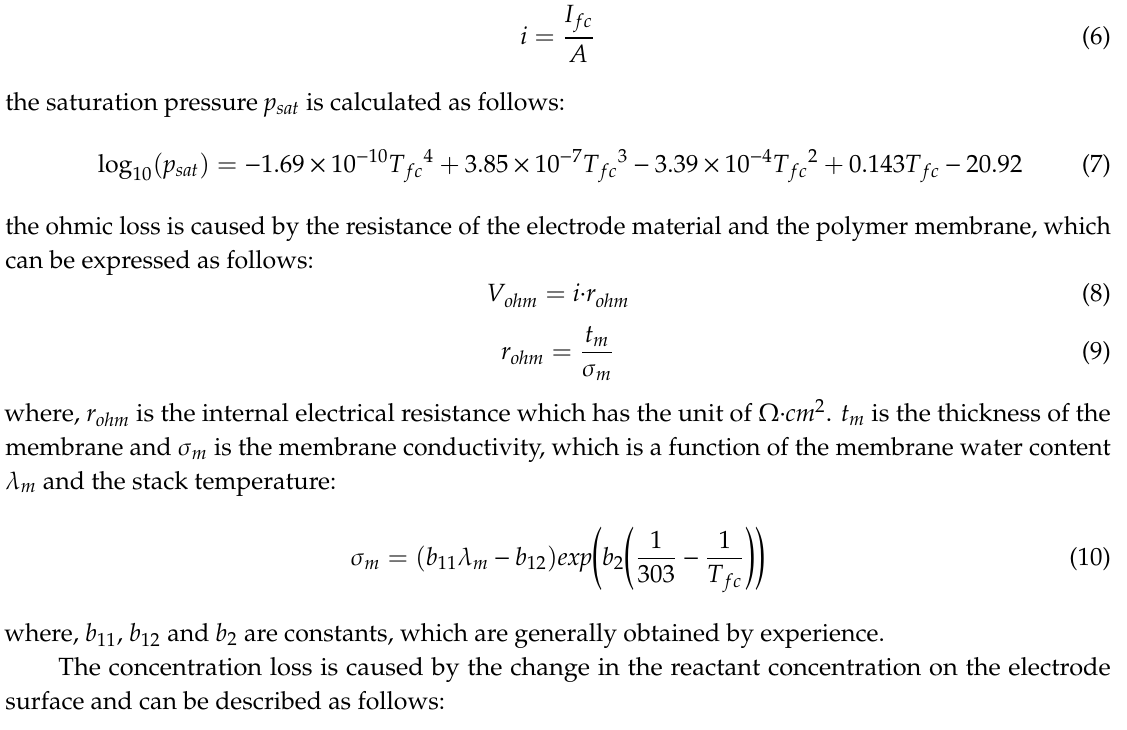
Table 1 is the parameter used in the fuel cell